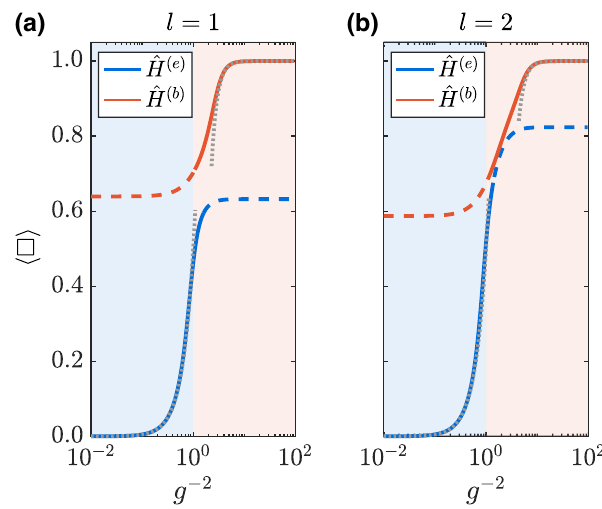
FIG. 10. The ground-state expectation value of the plaque- tte operator (cid:2) for a pure gauge periodic boundary plaquette (see Fig. 3). Results obtained using the electric and magnetic representation are shown as blue and red lines, respectively. Per- turbative calculations are shown as gray dashed lines. The plots correspond to two different truncations l = 1 and l = 2, as indi- cated above. The blue (red) shaded region indicates the values of g − 2 for which the electric (magnetic) representation achieves the best